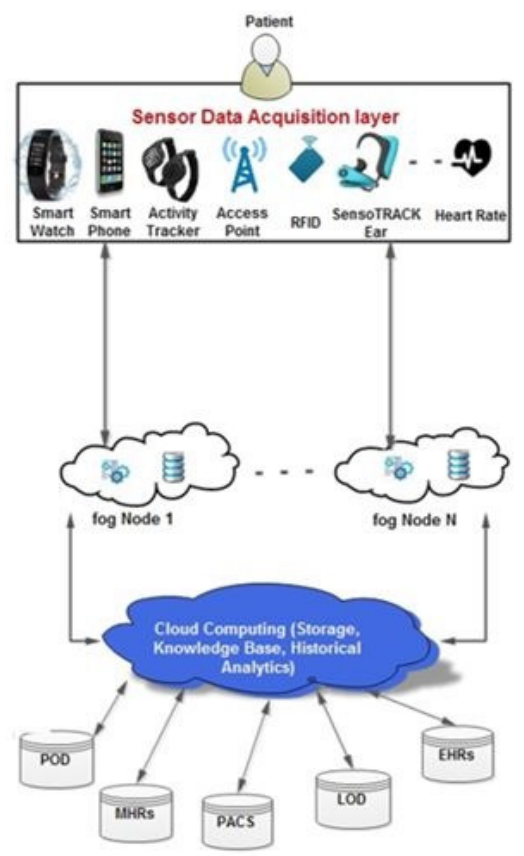
Figure 11. Representation of the components in the fog framework for wearable healthcare